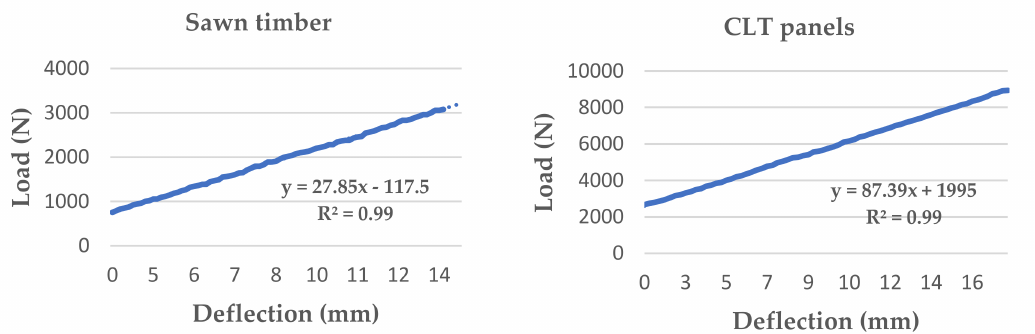
Figure 5. Load-displacement relation for a sawn timber beam and a CLT